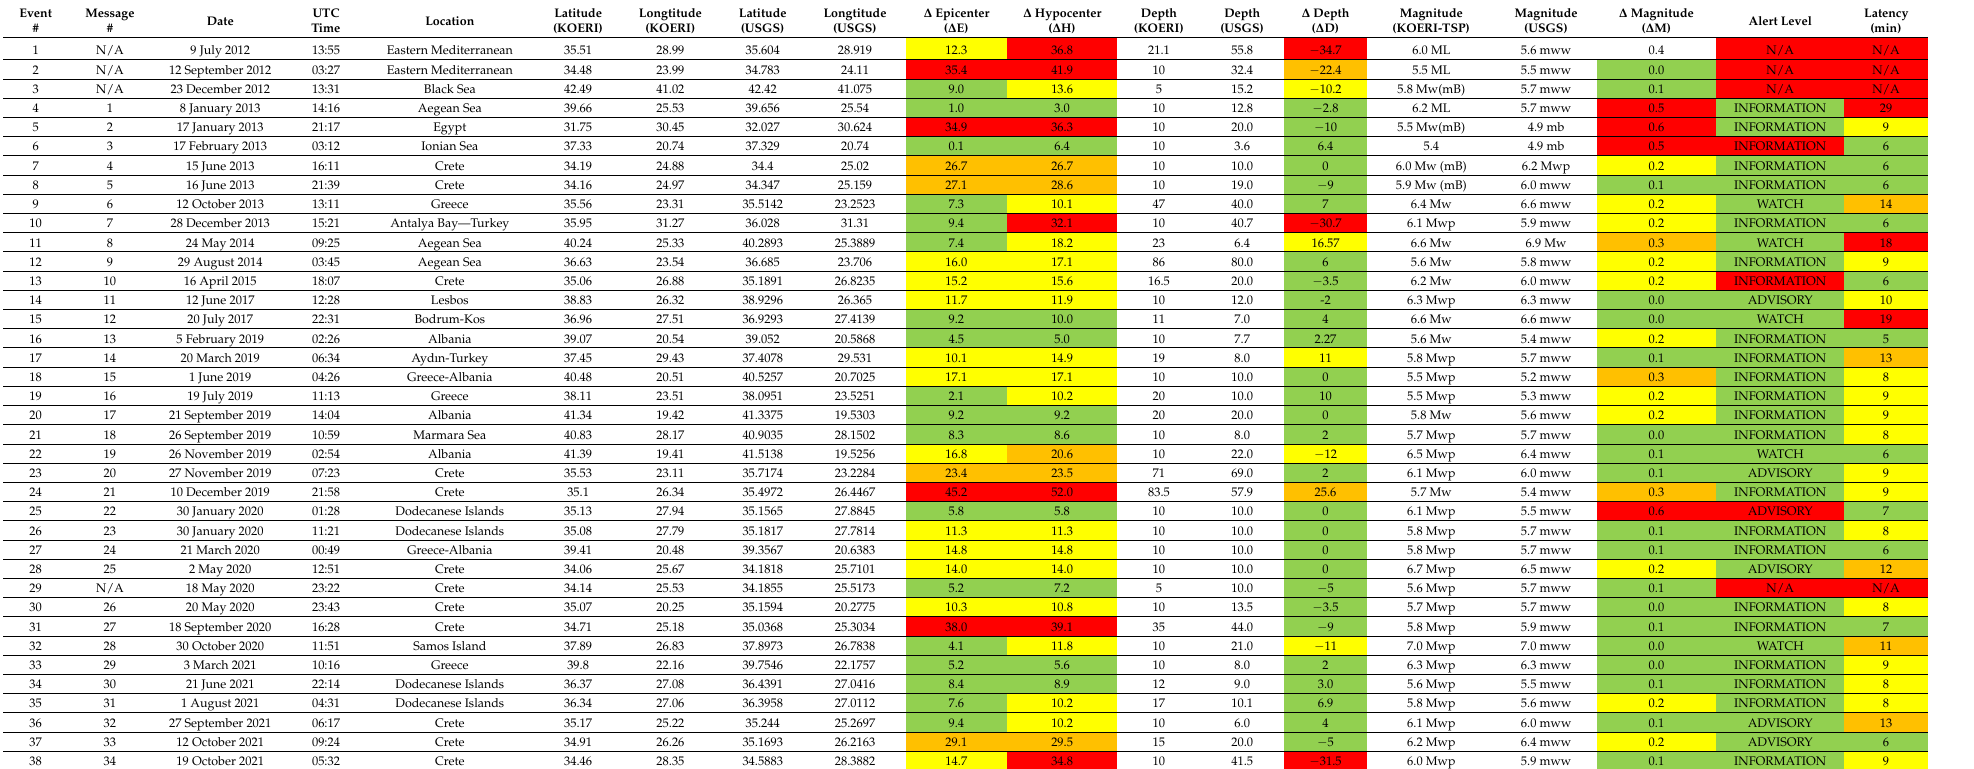
Table 2. List of events that necessitated dissemination of tsunami bulletins by KOERI–RETMC. Color codes represent different levels of performance (good (green), acceptable (yellow), poor (orange), bad (red)) associated to the following performance indicator metrics: Latency (min): good ( ≤ 7 min), acceptable (<7 min— ≤ 10 min), poor (<10 min— ≤ 15 min), bad (>15 min); ∆ M (difference between USGS final and KOERI alert message magnitude): good ( ≤ 0.1), acceptable (<0.1— ≤ 0.2), poor (<0.2— ≤ 0.3), bad (>0.3); ∆ D (depth error), ∆ E (epicentral error), ∆ H (hypocentral error) between USGS final and KOERI alert message): good ( ≤ 10 km), acceptable (<10 km— ≤ 20 km), poor (<20 km— ≤ 30 km), bad ( ∆ M > 30 km); Alert Level: good (correct), bad